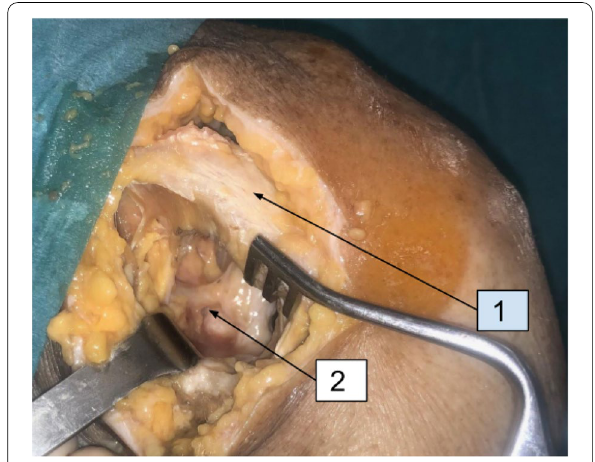
Fig. 5 Posterior approach. (1) Spine of the scapula; (2) Surpa-scapular nerve at the infra-spinatus